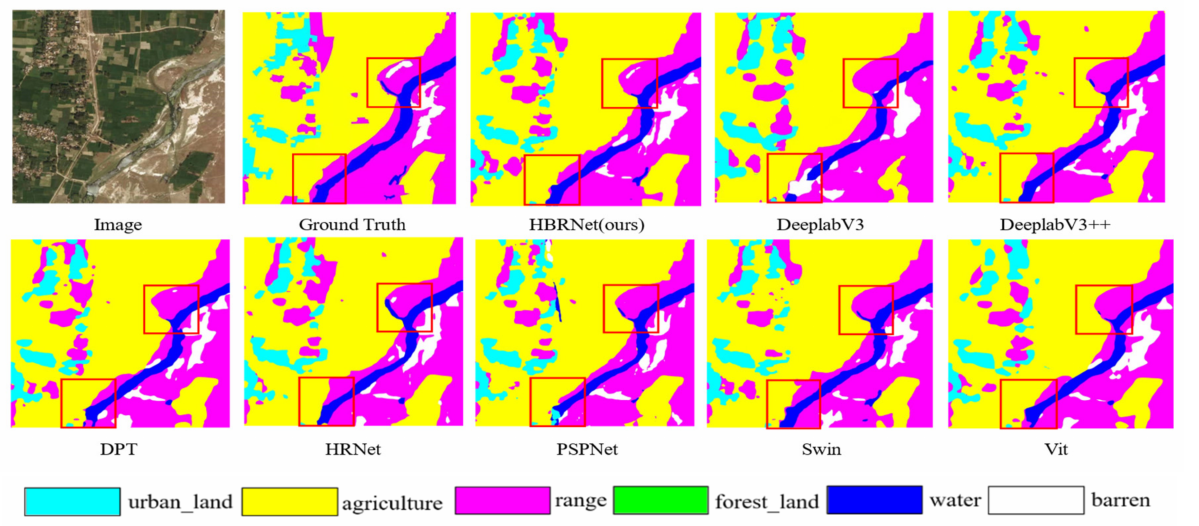
Figure 13. Visualization of results on the DeepGlobe dataset. We have marked some detailed information in the experimental results section with red boxes, and by comparing this information we can see which algorithms achieved better results.